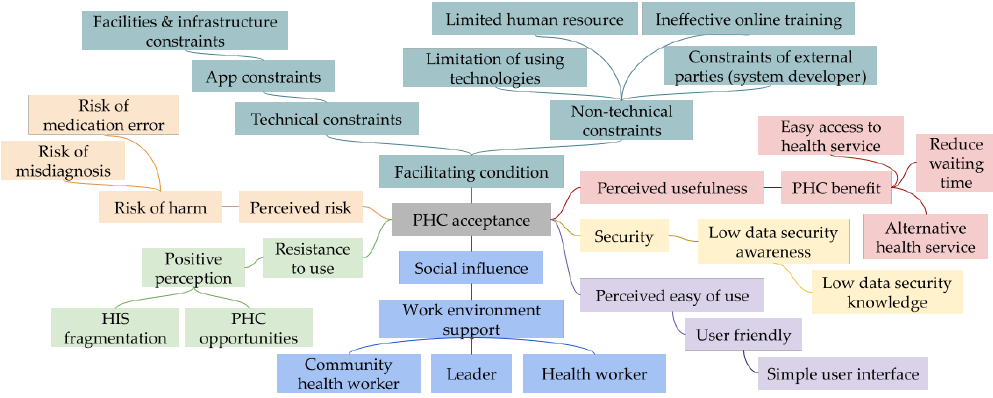
Figure 3. Mind map of PHC acceptance.